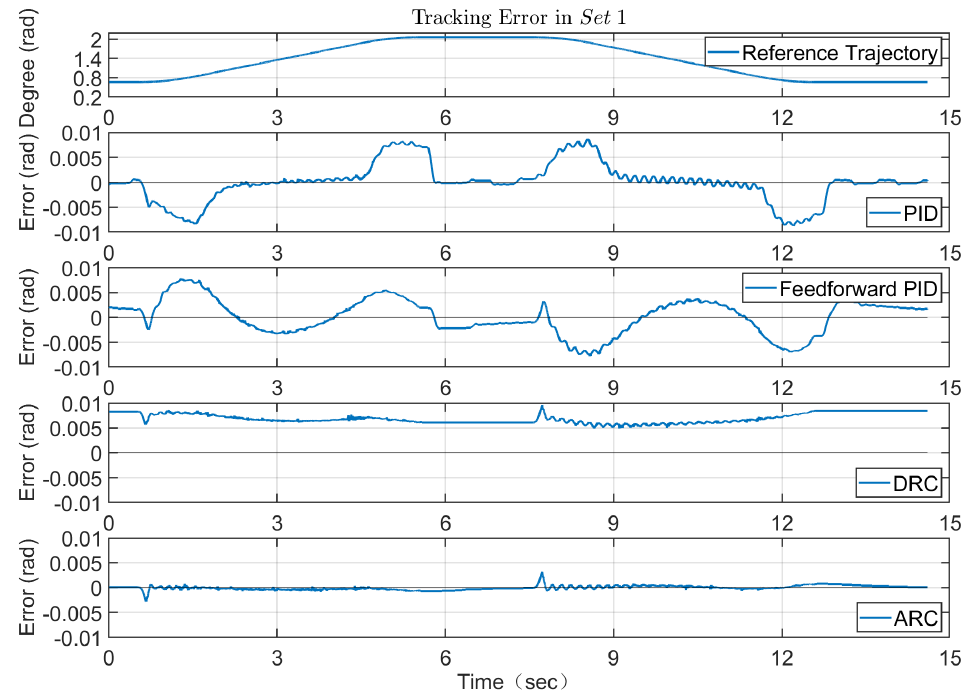
Figure 4. Point-to-point trajectory tracking error comparison diagram with Posture A.